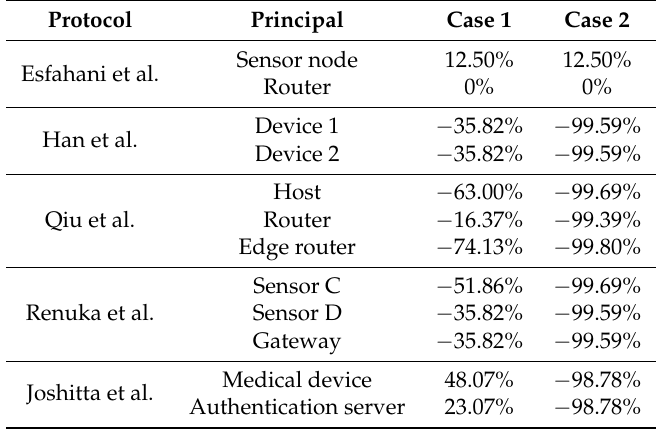
Table 9. The differences in percentages of execution-times of the schemes against LAKD.